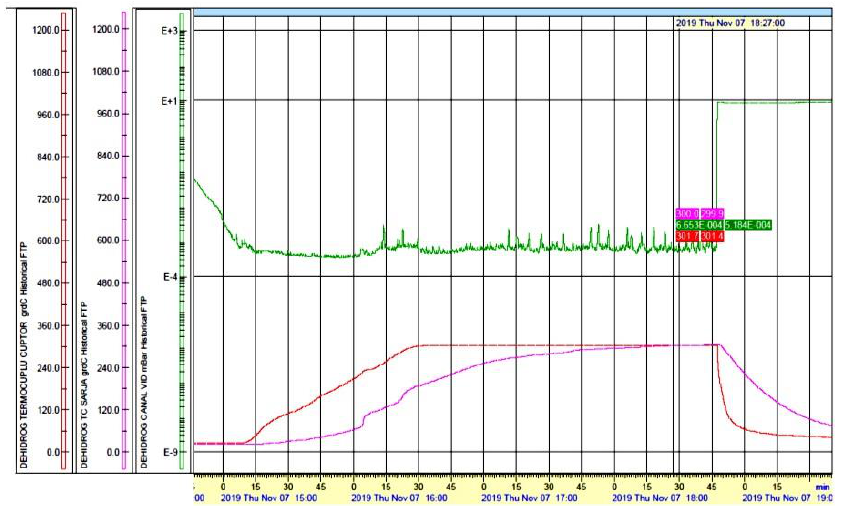
Figure 2. Process diagram for the pyrolysis under vacuum at 300 °C. Legend: pressure; batch temperature; oven temperature.